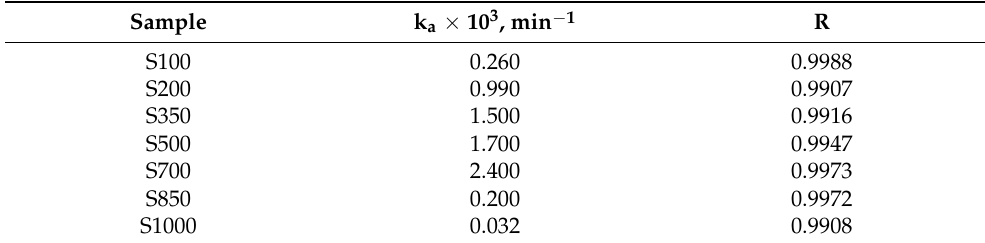
Table 1. Apparent rate constants (k a ) from the Langmuir–Hinshelwood treatment (see Equation (3)) based on CO 2 produced from the TiO 2 samples photosensitized oxidation of hexane (concentration: 600 ppm; reaction time: 1 h). R is the correlation coefficient.